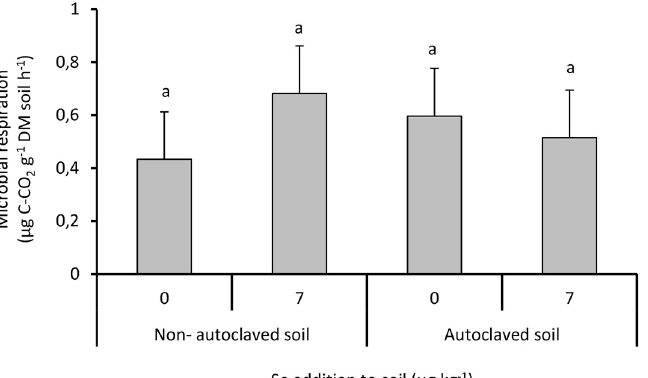
Fig.3. Microbial respiration rates (µg C-CO g -1 DM soil h -1 ) in non-autoclaved 2 or autoclaved soil with inorganic Se at 0 or 7 µg kg -1 after 24h incubation. Soil samples were taken when the plants were at the rosette stage. Data are given in means ± SE, n= 3. The same letter indicates no significant difference among bars with same colour, at p ≤ 0.05